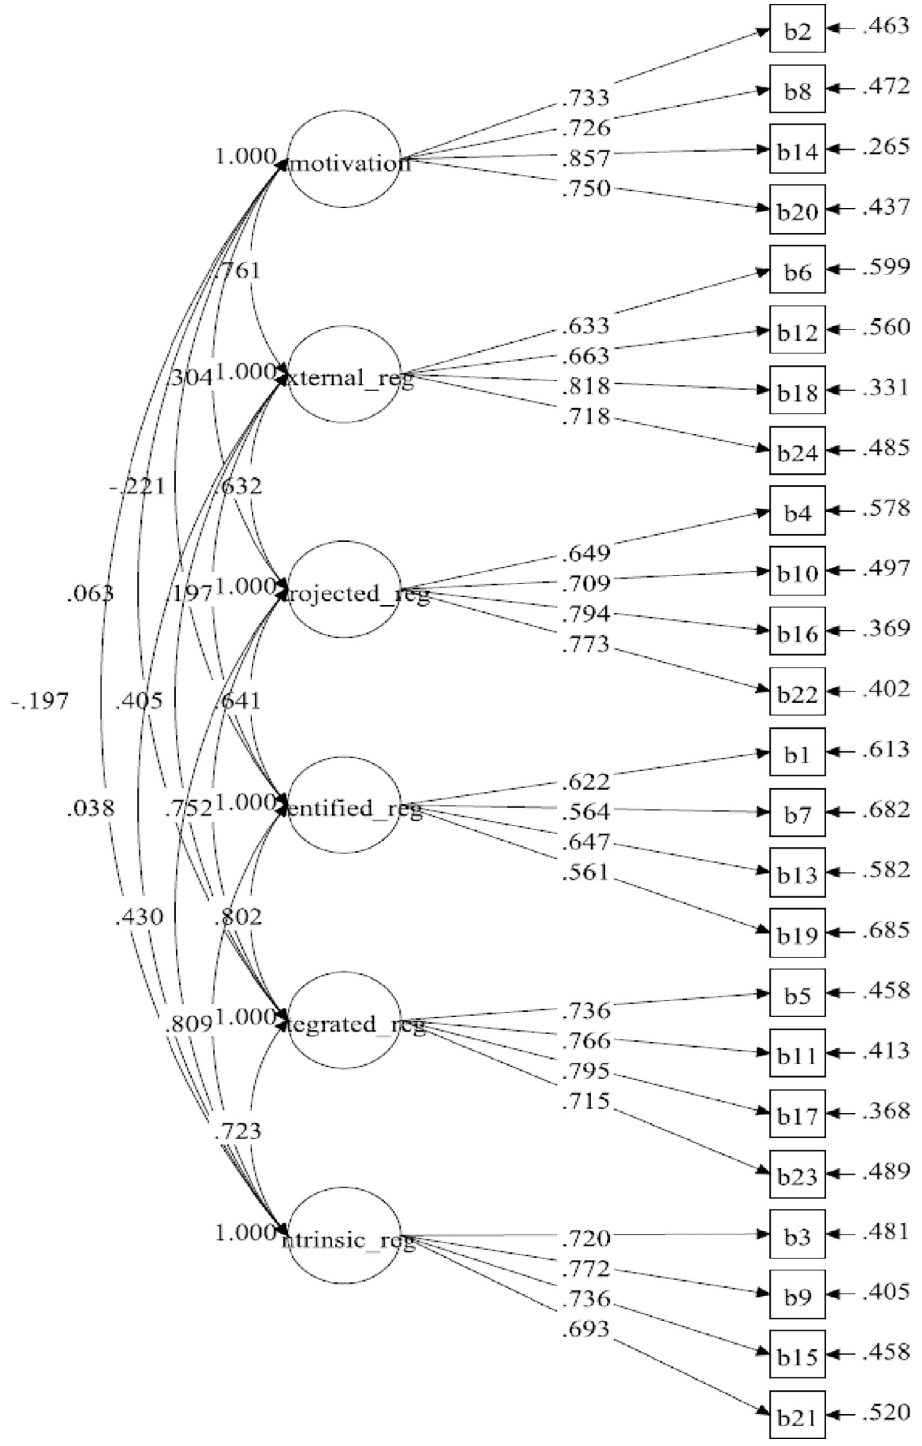
Fig 1. BREQ-3M measurement model (six-factor model